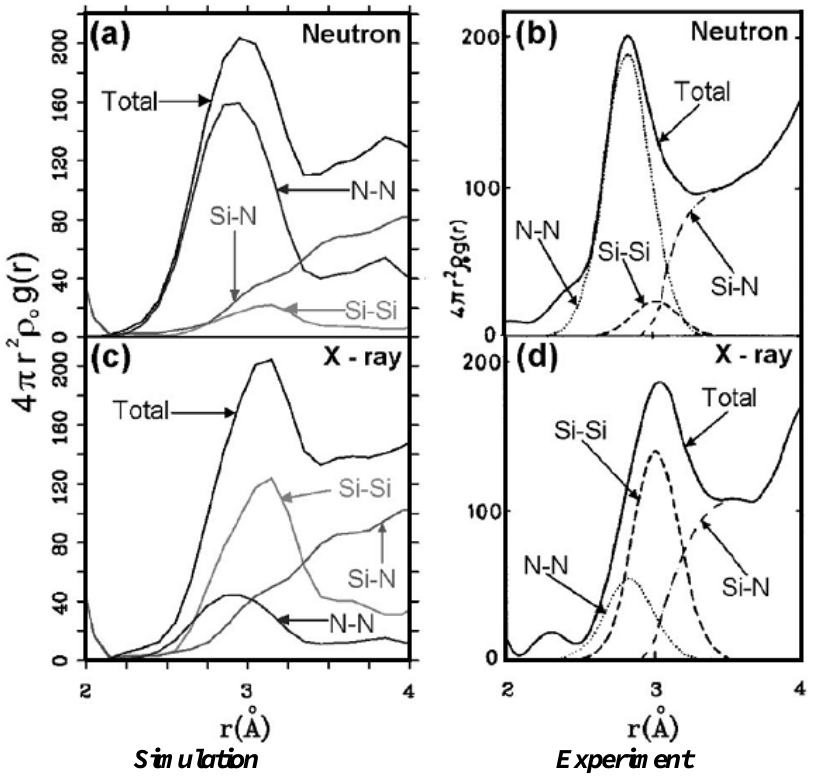
Figure 11. Comparison of the simulated ( a ) and ( c ), and experimental ( b ) and ( d ), structures of the second peak of the nearly stoichiometric sample when neutrons and X-rays are used, respectively. For this peak X-rays show a shift toward higher values of r with respect to neutrons, which is reproduced in our